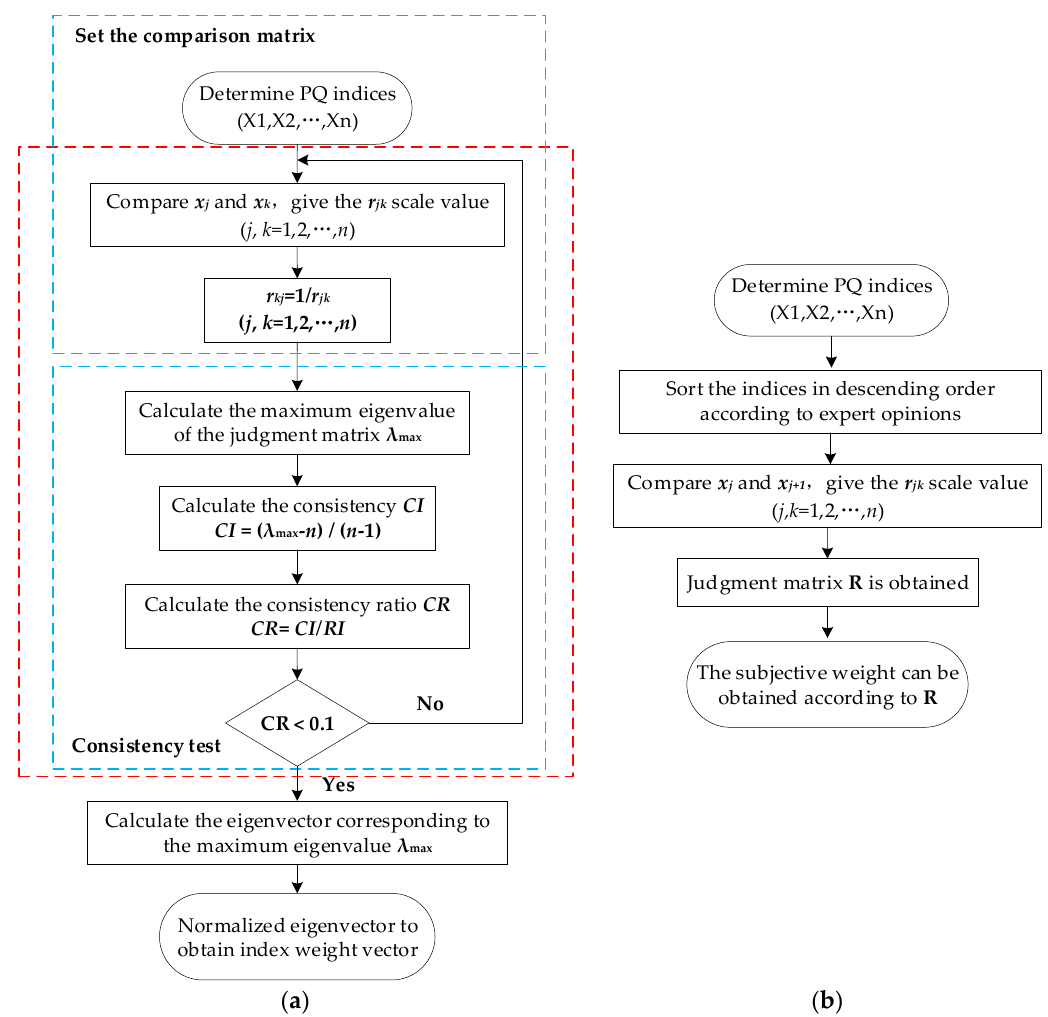
Figure 4. Comparison between traditional AHP and improved AHP: ( a ) flow chart of traditional AHP; ( b ) flow chart of improved AHP.